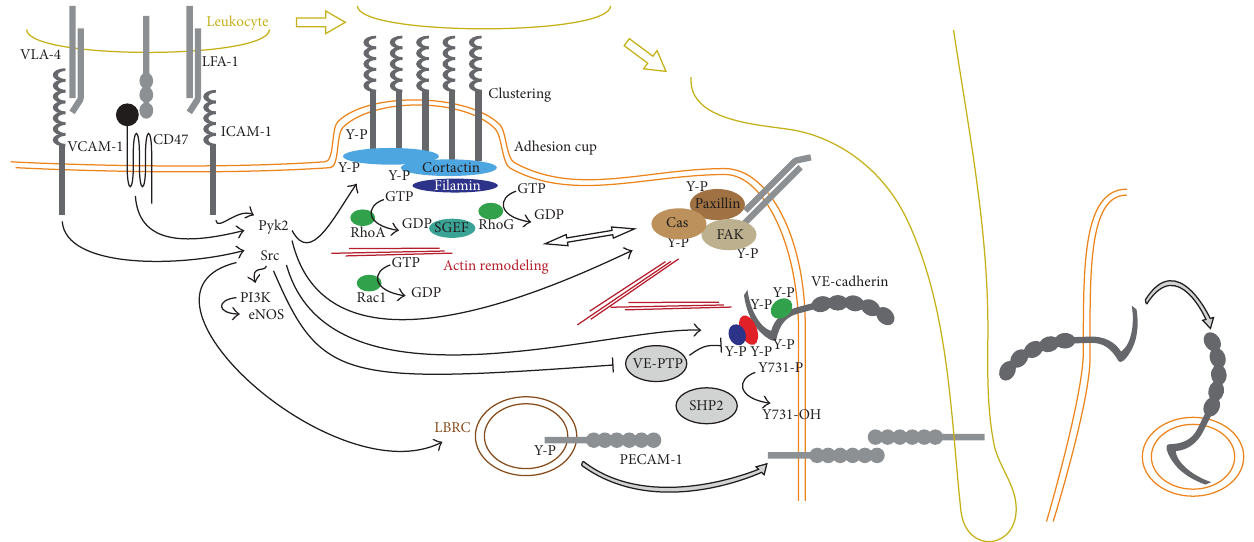
Figure 3: Simplified endothelial signaling cascades in response to leukocyte attachment. Adhesion of leukocytes through multiple transmembrane proteins such as ICAM-1, VCAM-1, and CD47 promotes activation of small GTPases (depicted as Rac1, RhoA, and RhoG) and PTK signaling, such as activation of Src and Pyk2. PTK activity leads to phosphorylation of actin binding proteins (e.g., cortactin) and focal adhesion components (FAK, paxillin, and Cas) that together with filamin promote ICAM-1 clustering and actin remodeling that is required for the formation of the adhesion cup. PTKs also promote the phosphorylation of VE-cadherin, which together with VCAM- 1-mediated dissociation of VE-PTP from VE-cadherin leads to junctional hyperphosphorylation. At the same time, SHP2 mediates VE- cadherin dephosphorylation specifically at tyrosine 731. VE-cadherin endocytosis may follow. Src-mediated phosphorylation of PECAM-1 is required from PECAM-1 translocation from the LBRC to the plasma